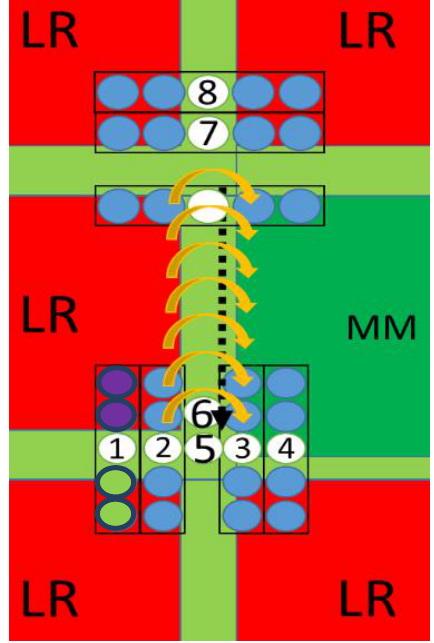
Figure 9. Catmull-rom interpolation. “TL” and “TR” represent the tangent points generated from surrounding maps. The “I” represents index position.